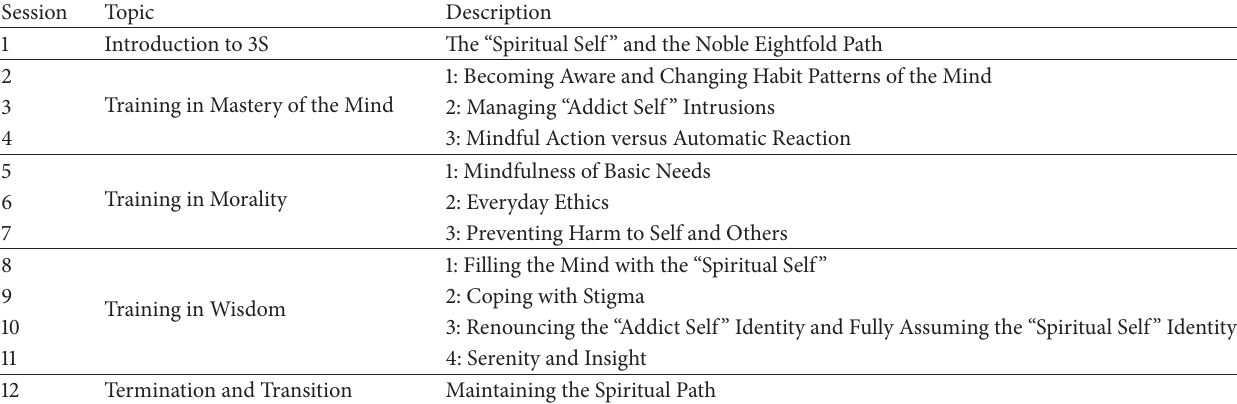
Table 1: Spiritual Self-Schema Therapy (3S): outline of weekly